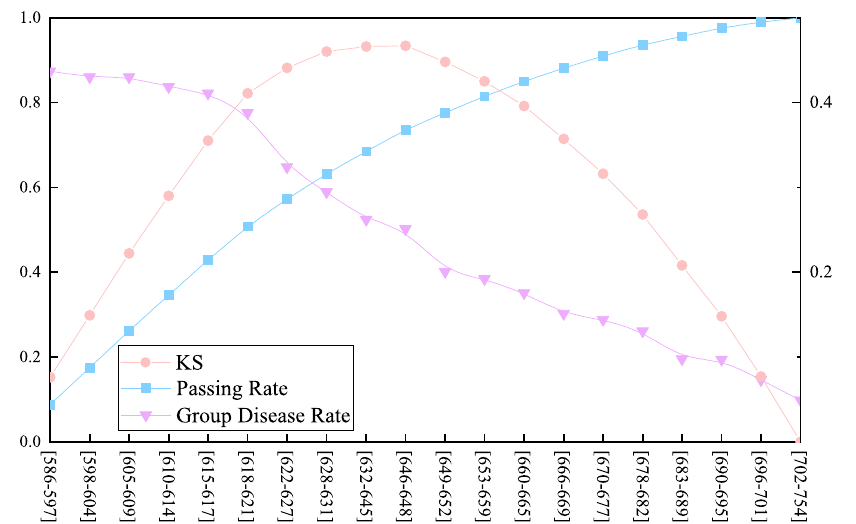
Figure 3. Performance graph of the scorecard model. The blue line represents the passing rate within the group, the orange line represents the change in the KS value, and the purple line represents the probability of disease within the